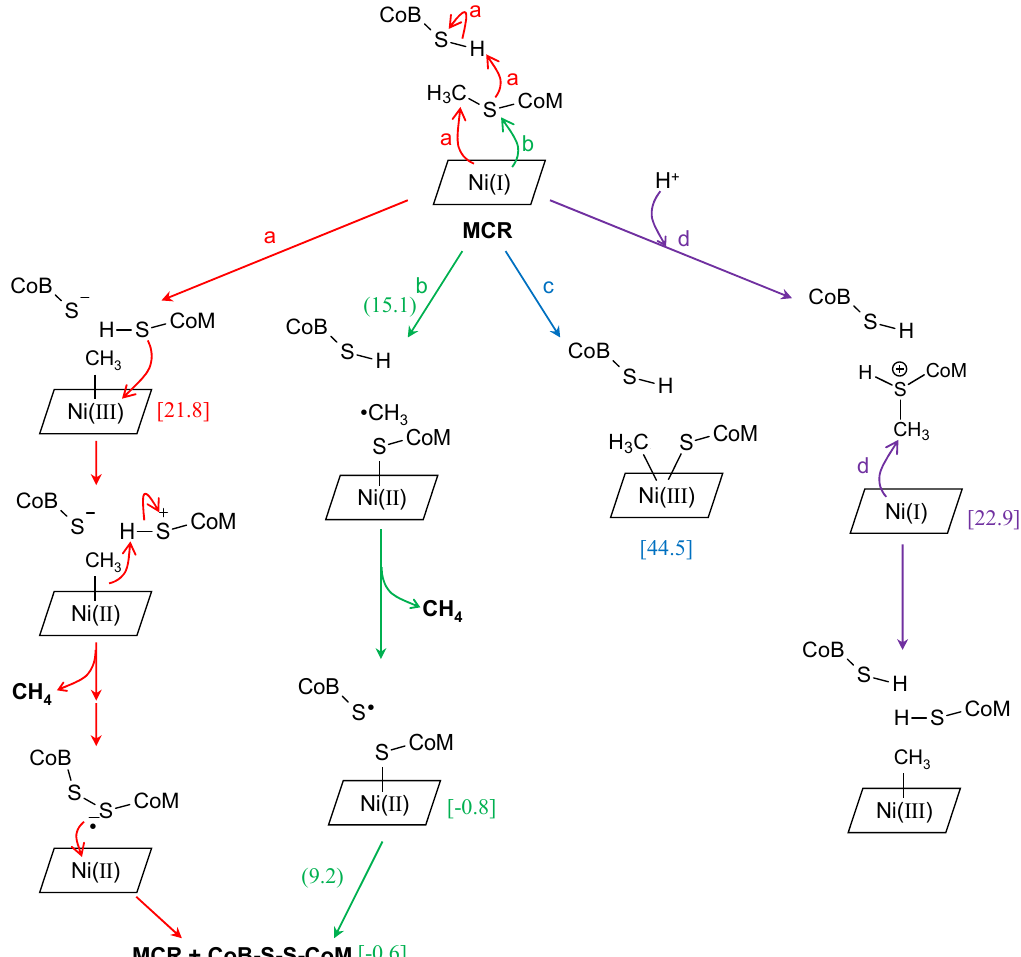
Figure 5. Four proposed mechanisms for the MCR reaction. ( a ) Mechanism I, including a methyl-Ni(III)F 430 intermediate. ( b ) Mechanism II, involving a methyl radical and a CoM–S–Ni(II)F 430 intermediate. ( c ) Mechanism III ,including a ternary intermediate with side-on methyl and CoM–S − coordinating to Ni. ( d ) Mechanism IV, involving a proton binding at the sulfur of CH 3 –SCoM. The energies for minima and transition states are given in brackets and parentheses, respectively. The